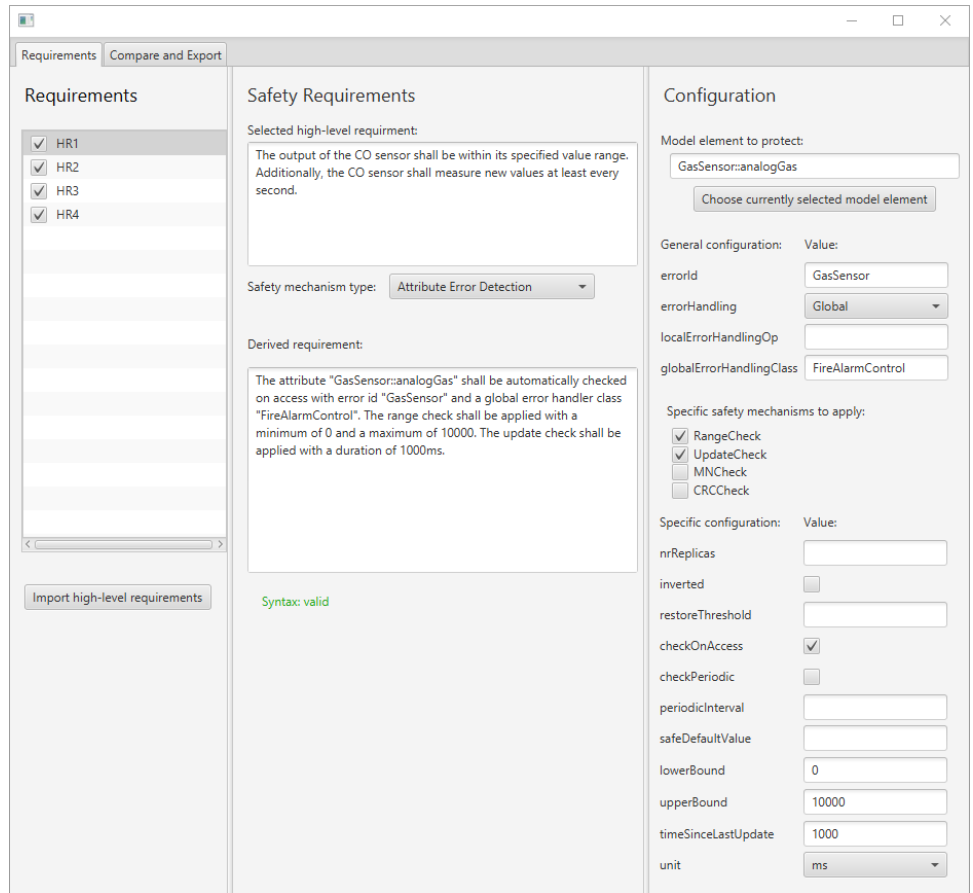
Figure 7. Screenshot of the prototype for automatically applying safety stereotypes to the application